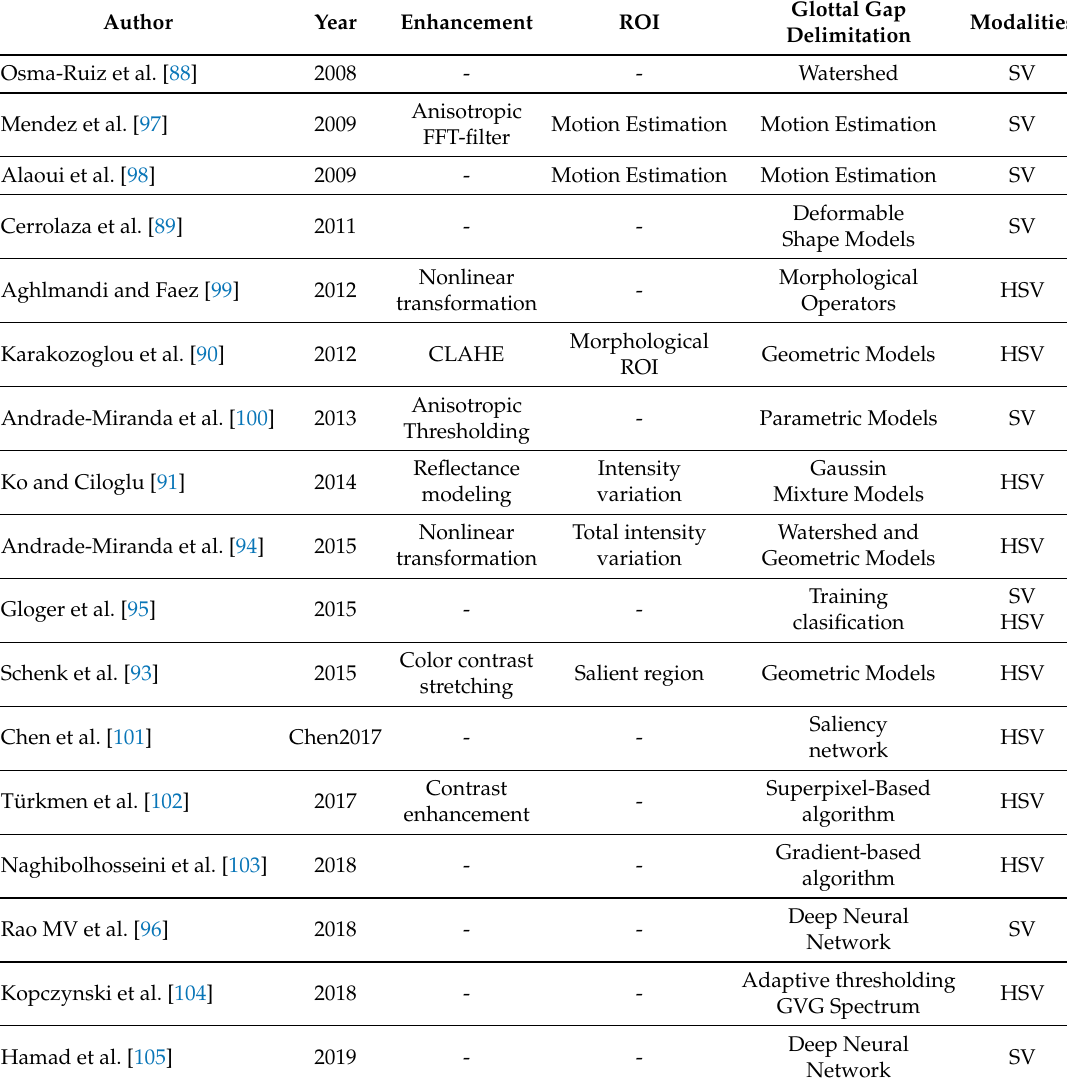
Table 2. Summary of the main automatic studies carried out to segment the glottal gap. First column corresponds to the authors. Second, year of publication. Third, enhancement technique. Fourth, ROI detection. Fifth, segmentation algorithm. Sixth, laryngeal image